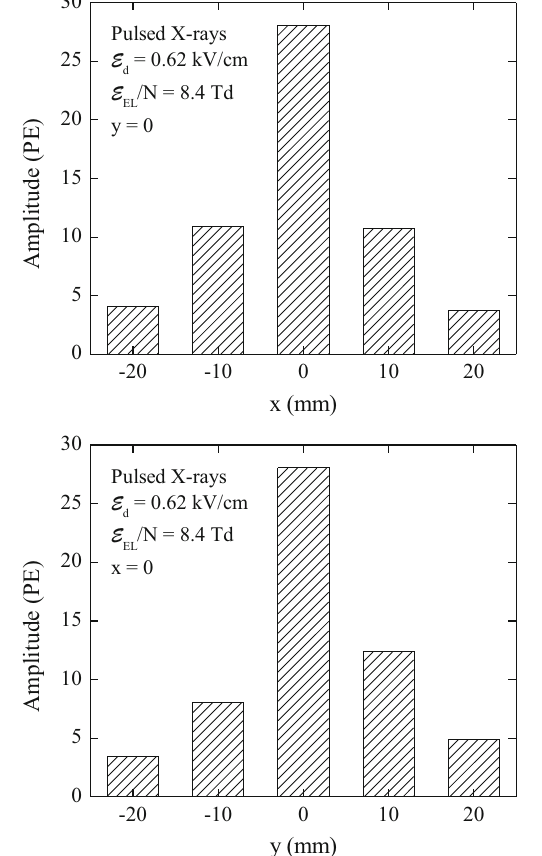
Fig. 17 Direct SiPM-matrix readout: 2D cross-section of Fig. 16 at y = 0 (top) and x = 0 (bottom)